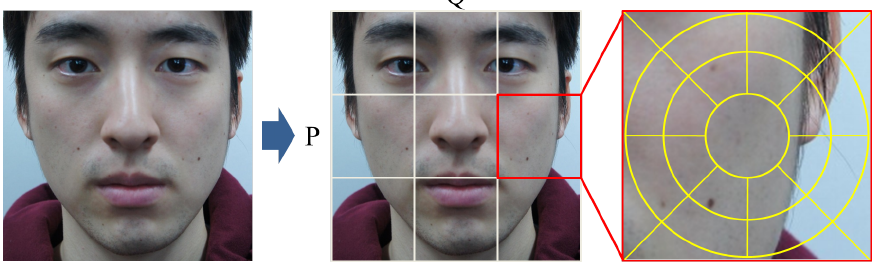
Figure 15. Patches in an image and polar location grids in a patch (patch size: 50 × 50).